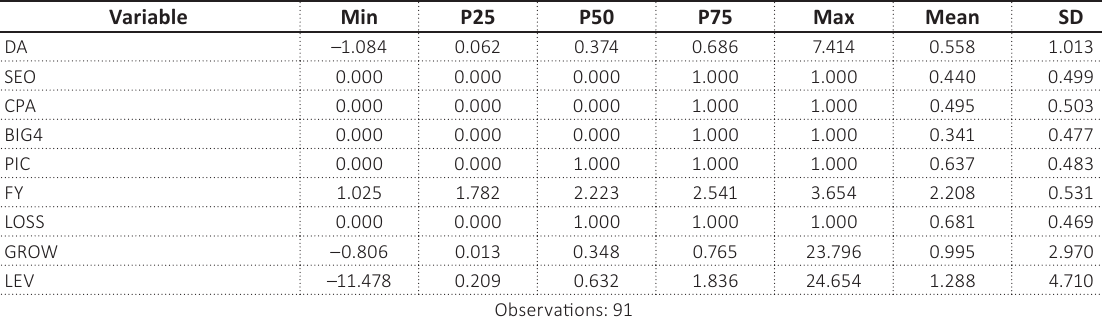
Table 4. Descriptive statistics for GISA